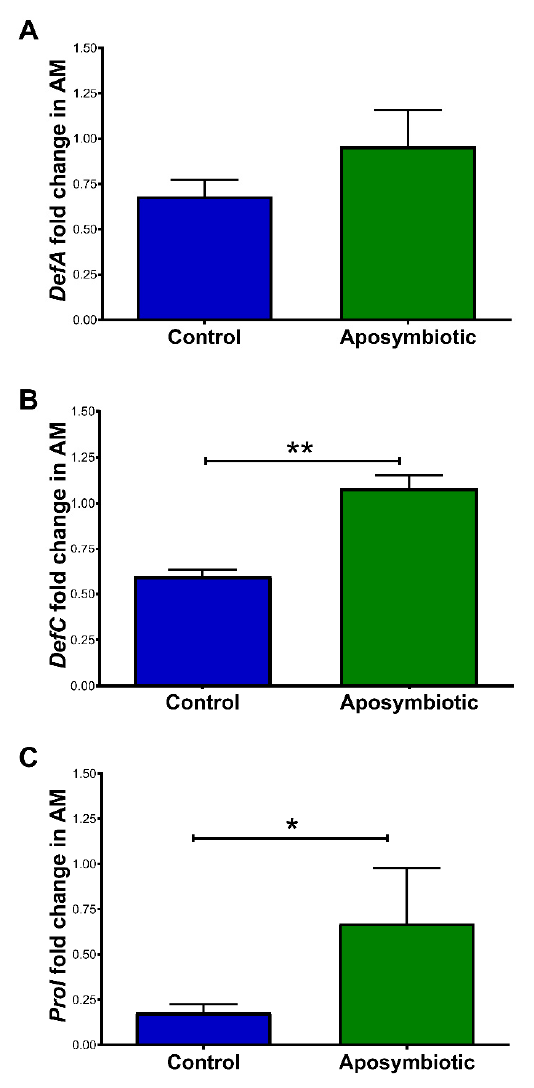
Figure 6. Relative expression of antimicrobial peptide genes in the anterior midgut (AM) of Rhodnius prolixus 1st instar nymphs 5 days after feeding. ( A ) DefA ; (B ) DefC ; ( C ) Prol . Treatments: control group: eggs and insects were kept in contact with adult feces; aposymbiotic group: eggs previously treated with povidone-iodine 1% and maintained in sterile conditions. Data were quantified using the gene expression of control insects as the calibrator. Each bar represents the mean of relative quantification (RQ) values of 2 independent experiments—2 pools of 5 tissues each, with a total of 20 insects ( n = 4). Bars represent the mean of 2 independent experiments—2 pools of 5 tissues each, with a total of 20 insects ( n = 4). ∆∆ Ct values were analyzed by an unpaired Student’s t -test, * p < 0.05; ** p <